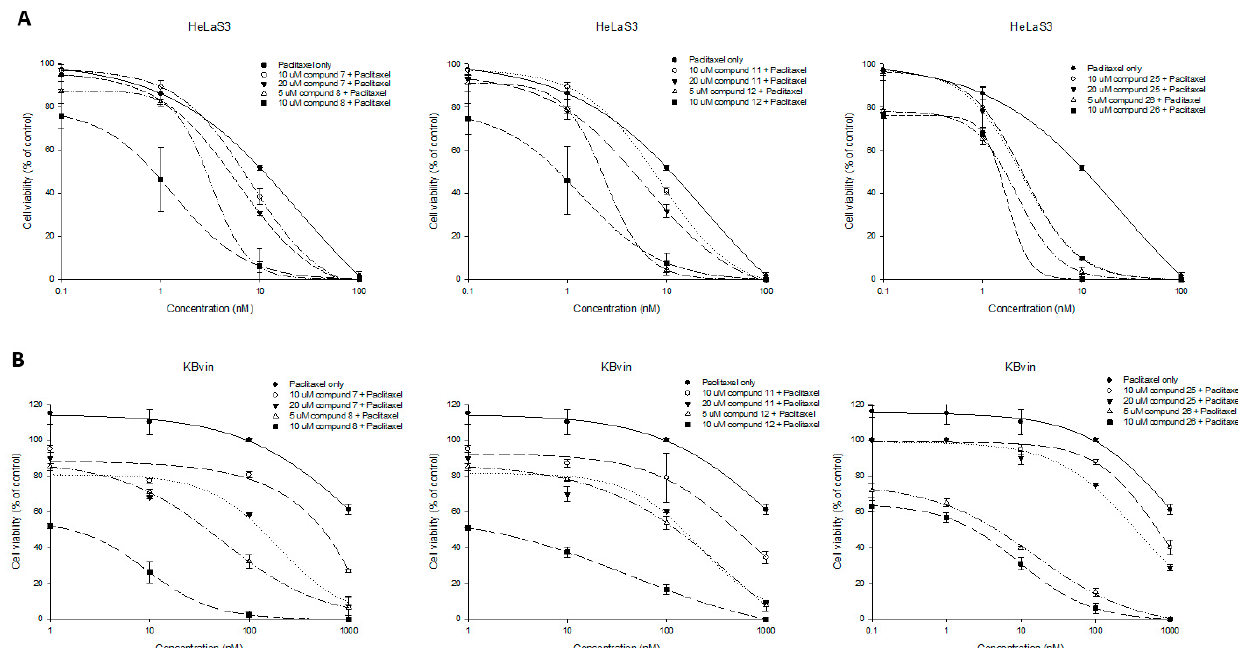
Figure 3. Reversal fold values of zhankuic acid type compounds and their methyl esters in KBvin and HeLa S3 cells. For R 5 acid-substituted compounds (odd compound number), the low concentration (conc.) was 10 μ M, and the high conc. was 20 μ M. For the R 5 ester-substituted compounds (even compound number), the low conc. was 5 μ M, and the high conc. was 10 μ M.